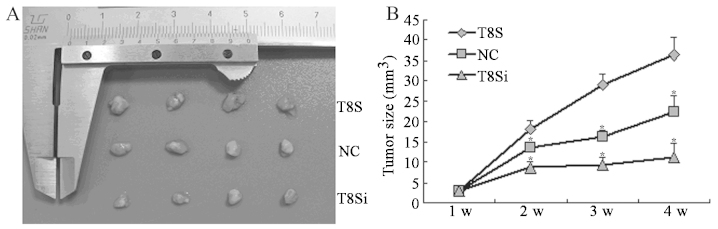
Tumor growth in the nude mice injected with T8S, T8Si or non-transfected cells within four weeks post-injection. (A) Representative image of tumor. (B) The tumor growth curve showed a significant growth tendency in mice injected with T8S cells (*P<0.05 compared to the NC and T8si group).